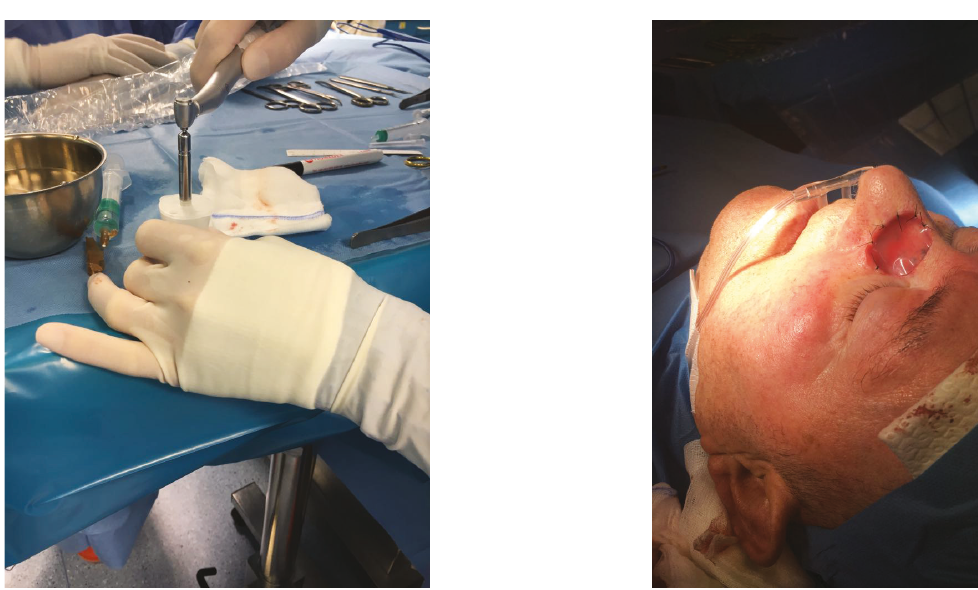
Figure 7: Cover of the postsurgical soft tissue loss with Integra® dermal substitute.